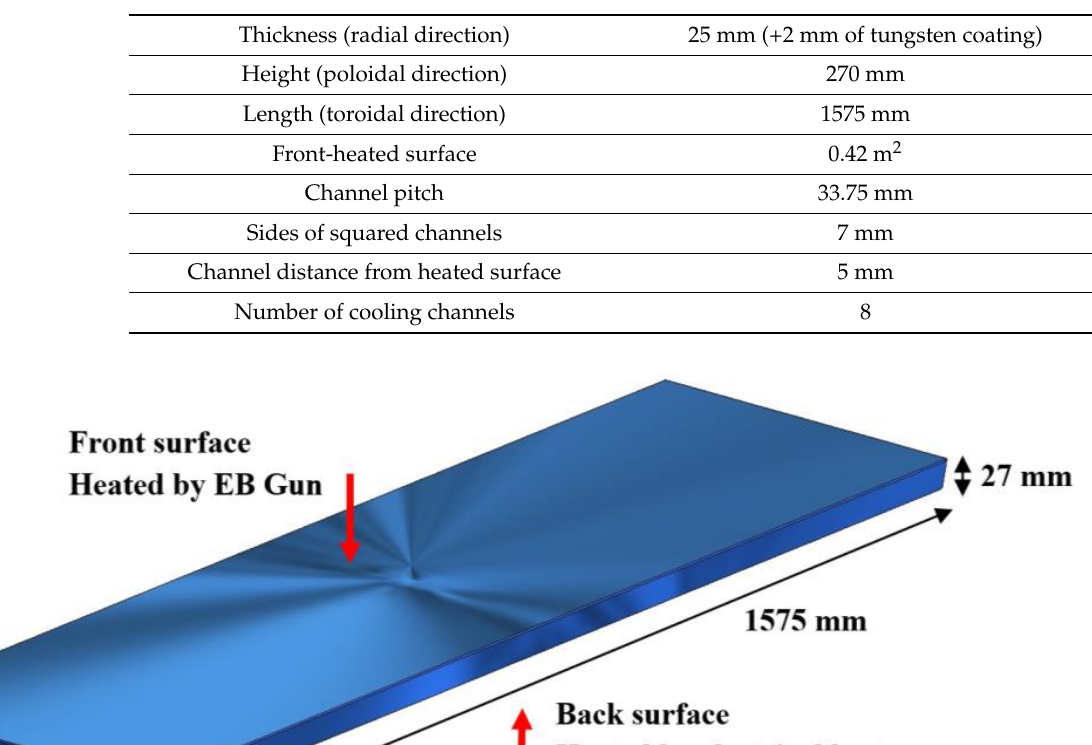
Table 2. Main dimensions of the FW – MU.